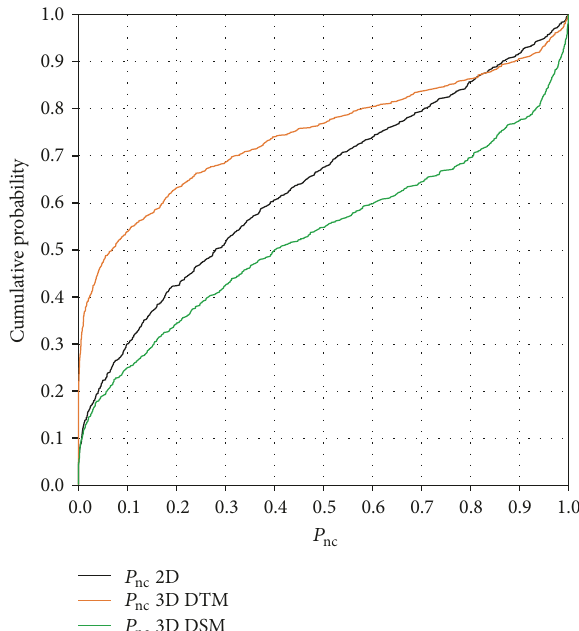
Figure 4: Empirical cumulative distribution of 𝑃